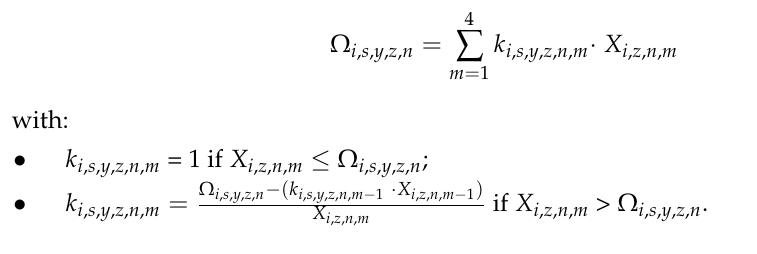
Table 1. Correlation matrix between solar and wind technologies’ producibilities. Area “z”